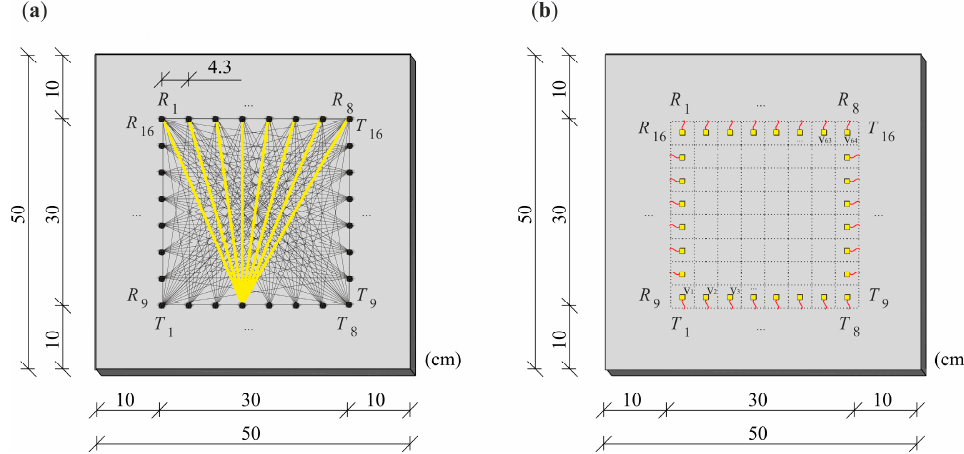
Figure 5. The plate with the marked inspected area: ( a ) location of transmitters T 1 – T 16 and receivers R 1 – R 16 , ( b ) division of the area into pixels.